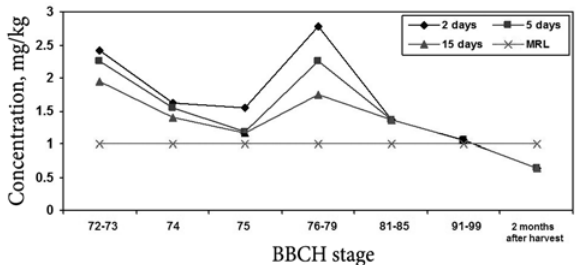
Fig. 9. Degradation of tebuconazole in Jonathan apples